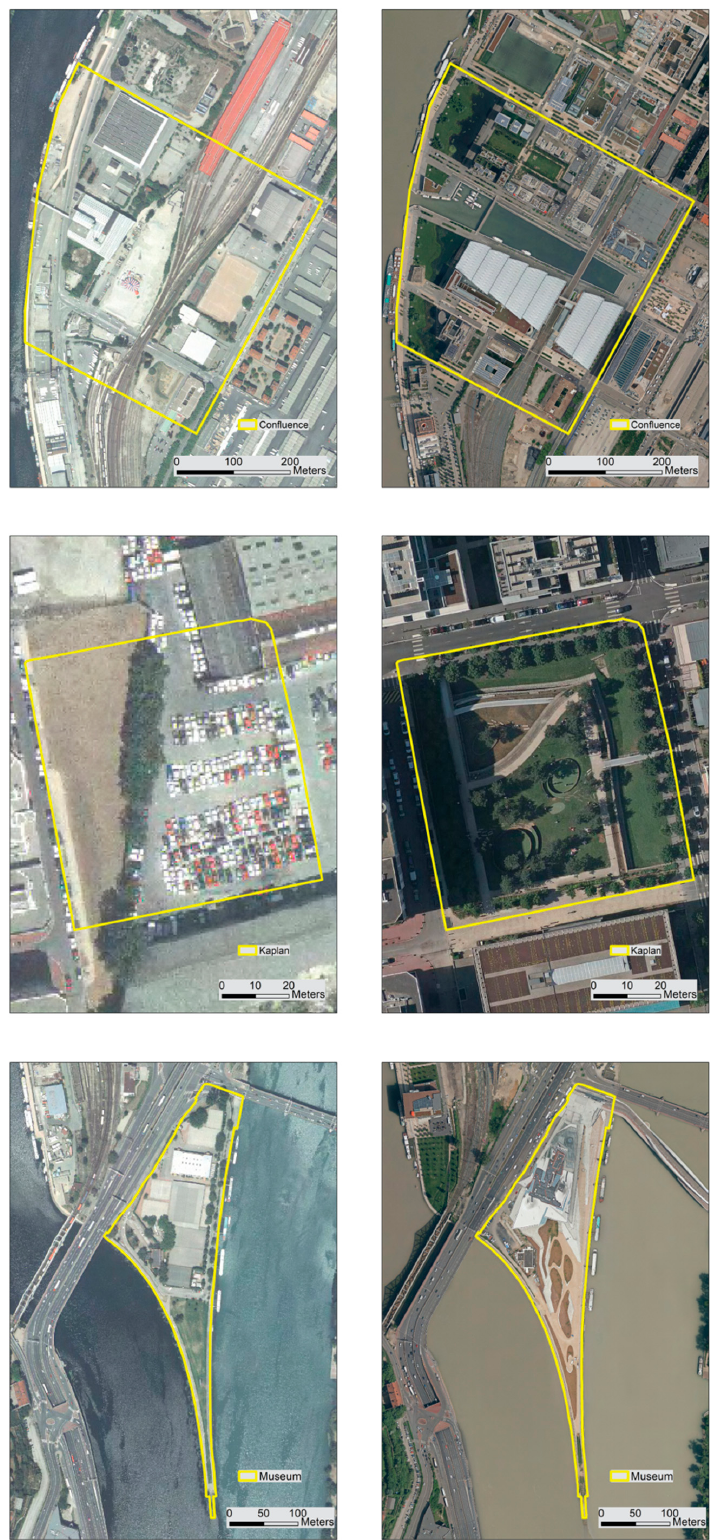
Figure 2. Confluence (top), Kaplan Park (middle), and Museum sites in 2003 (left) and 2015 (right).